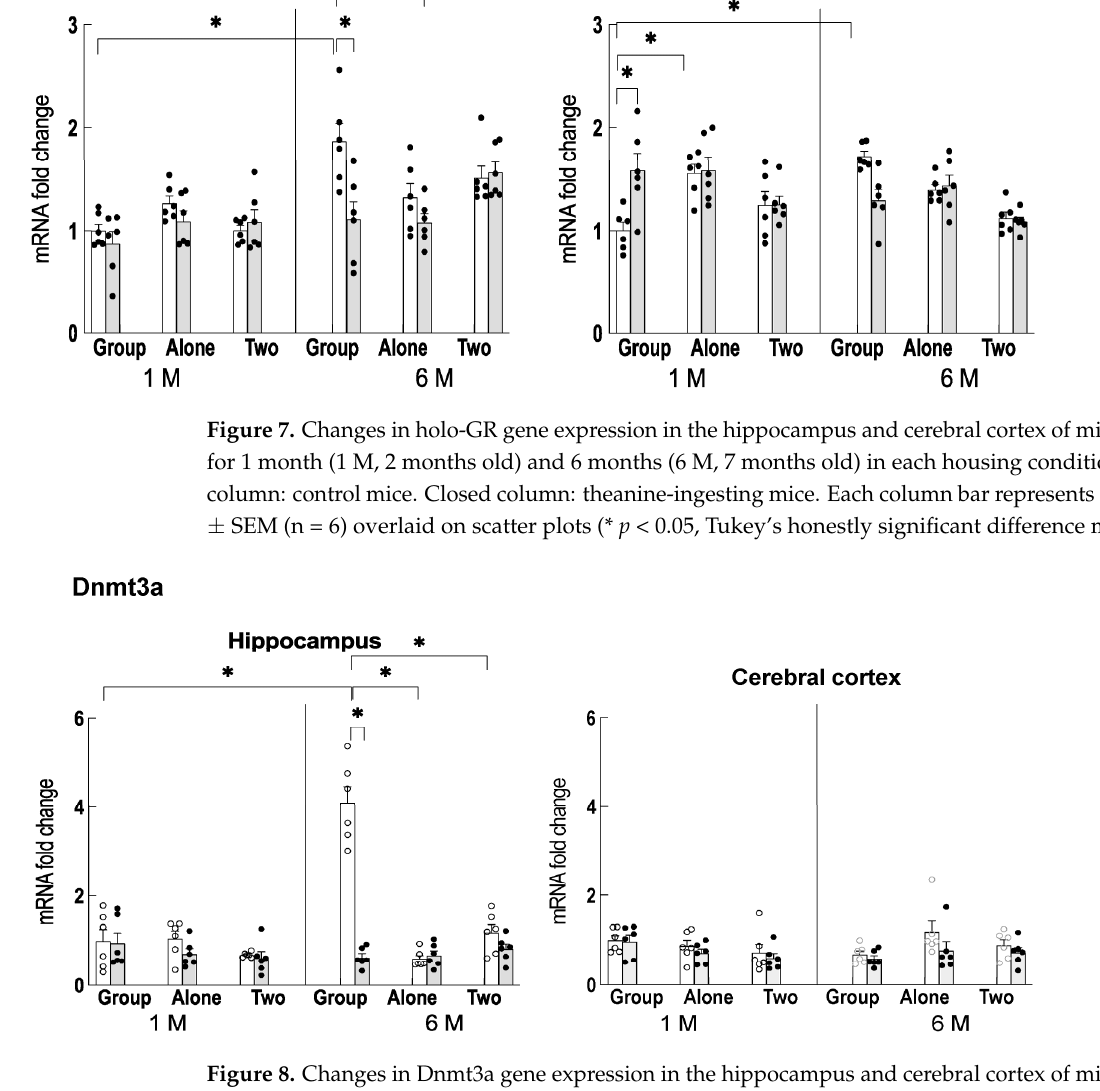
Figure 8. Changes in Dnmt3a gene expression in the hippocampus and cerebral cortex of mice reared for 1 month (1 M, 2 months old) and 6 months (6 M, 7 months old) in each housing condition. Open column: control mice. Closed column: theanine-ingesting mice. Each column bar represents the mean ± SEM (n = 6) overlaid on scatter plots (* p < 0.05, Tukey’s honestly significant difference